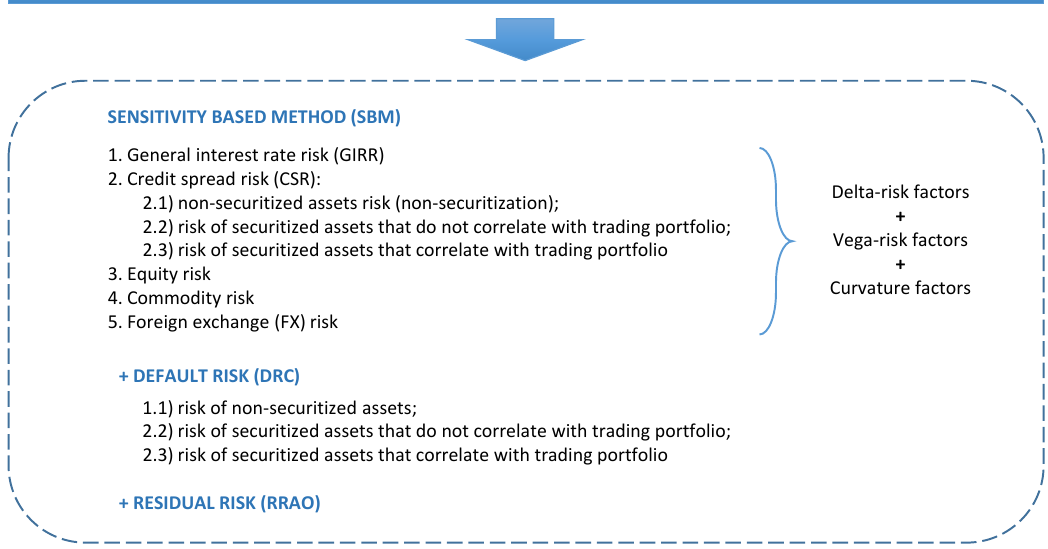
STANDARDIZED APPROACH (SA) TO THE MARKET RISK